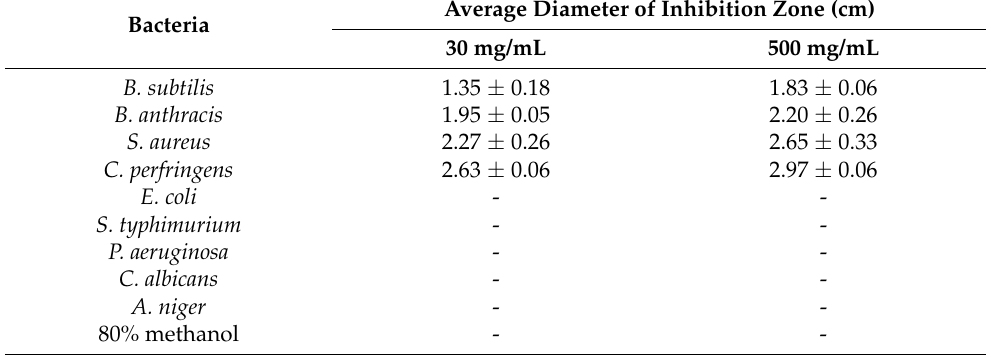
Table 2. Diameter of inhibition